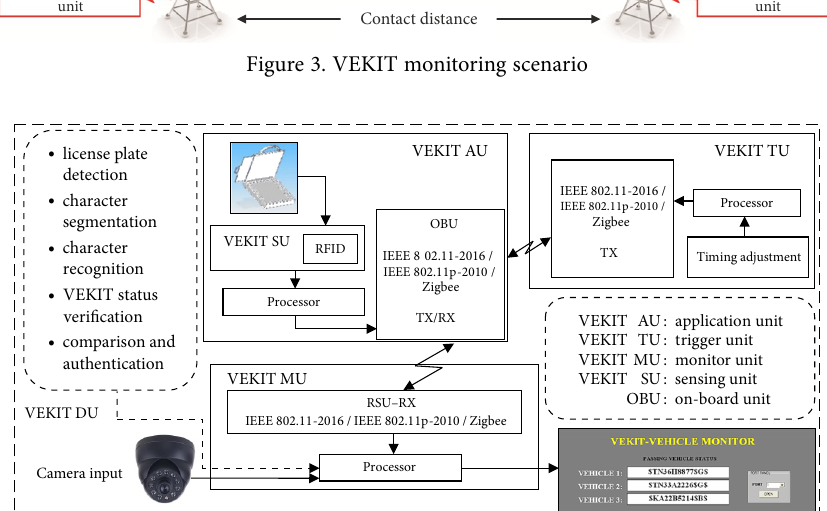
Figure 4. Components of the VEKIT monitoring